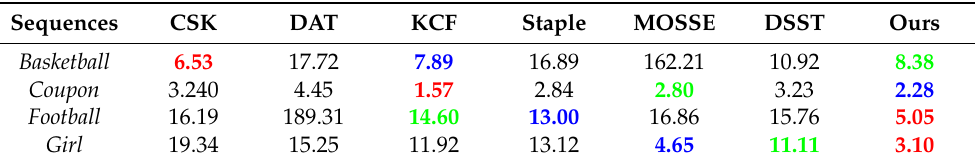
Table 1. Comparison results in terms of average CLE (in pixels). The best three estimates are marked in red, blue, and green fonts in descending order.